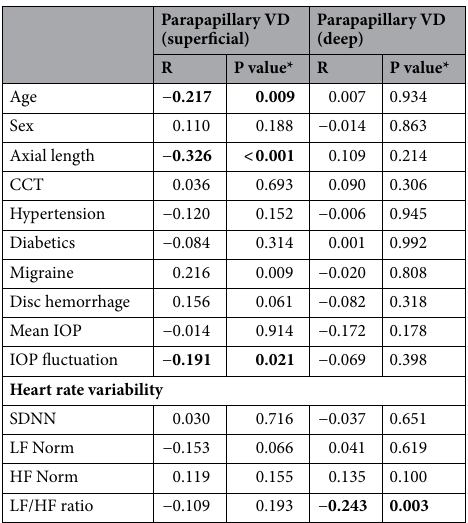
Parapapillary choroid vessel density